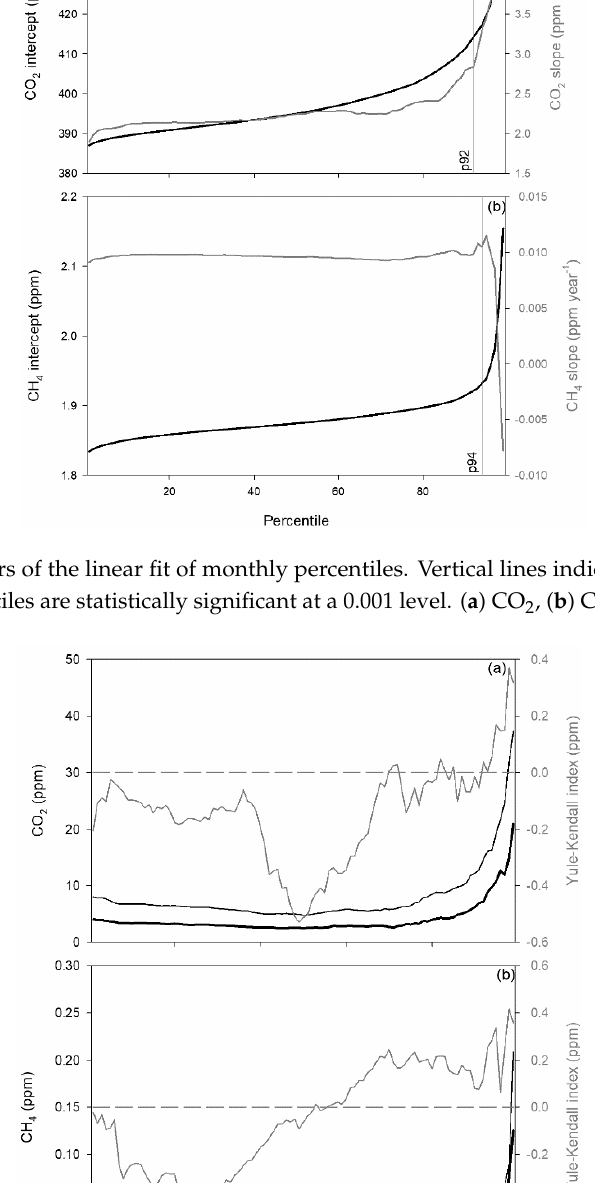
Figure 6. Statistics of percentiles of detrended residuals. The lowest thick black line is the median of the absolute value, and the highest thin black line is the interquartile range. ( a ) CO 2 , ( b ) CH 4 . The Yule–Kendall index is the grey